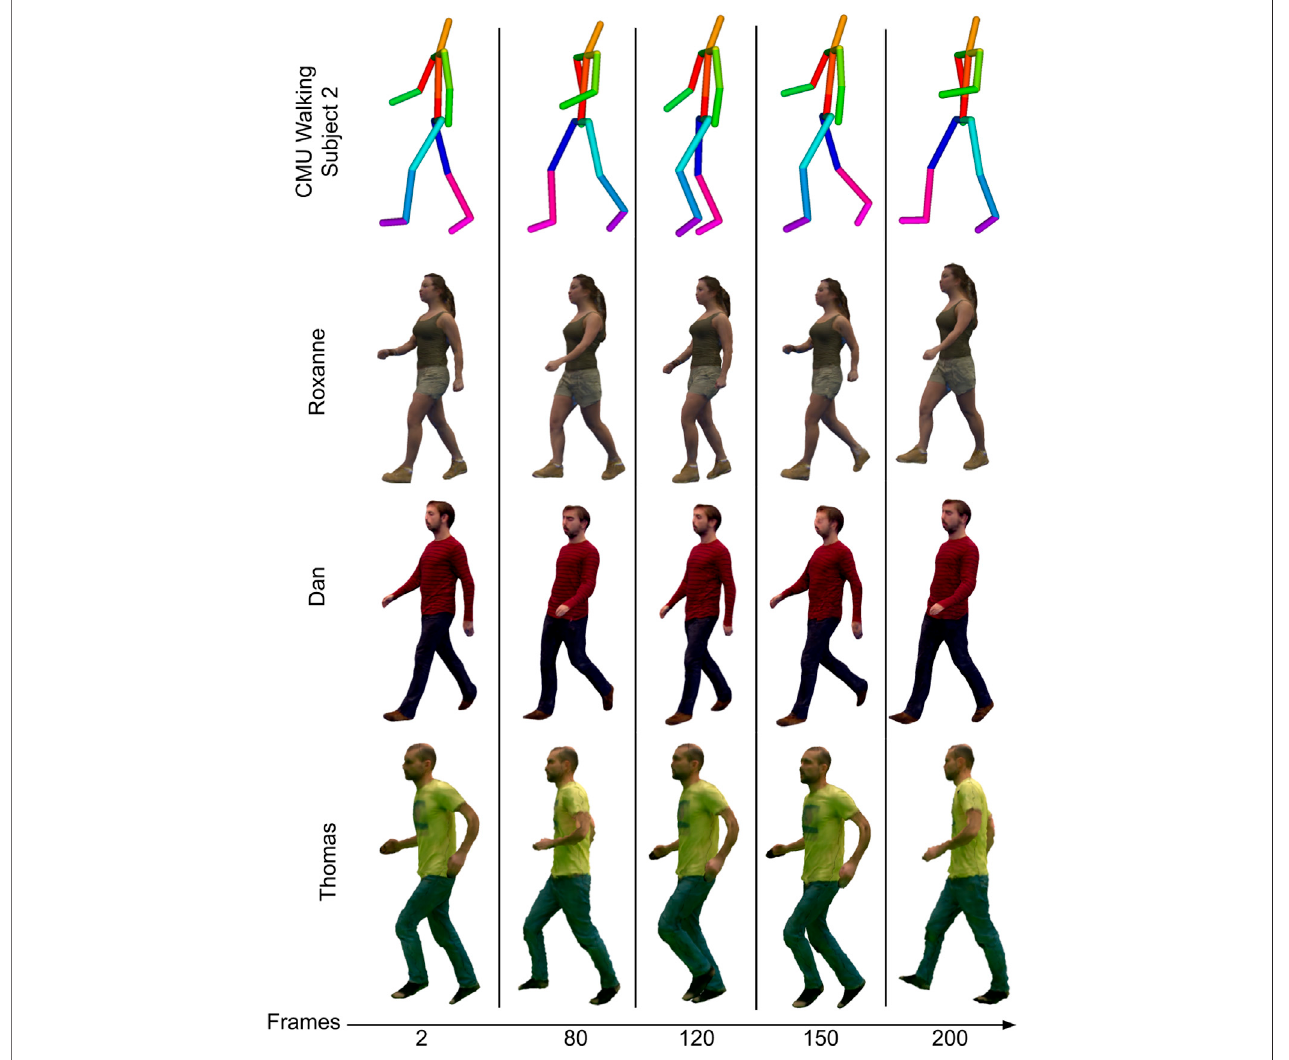
FIGURE12| Thetoprowisamotioncapturesequencewhichisusedtosynthesisethebottomrows.Thebottomrowsare4DvolumetriccontentofRoxanne.Dan and Thomas datasets. It is visible that is able to generate 4D volumetric video from skeletal motion for different subjects.